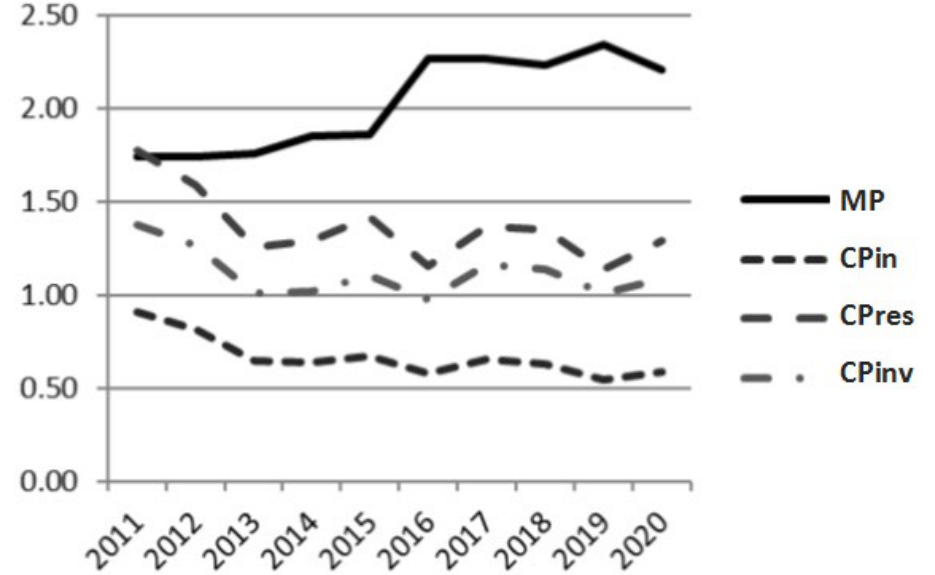
Figure 5. Material and capital productivity value dynamics for Boliden AB. MP—material productivity; CPinv—indicator calculated based on initial CP values of machinery and equipment.